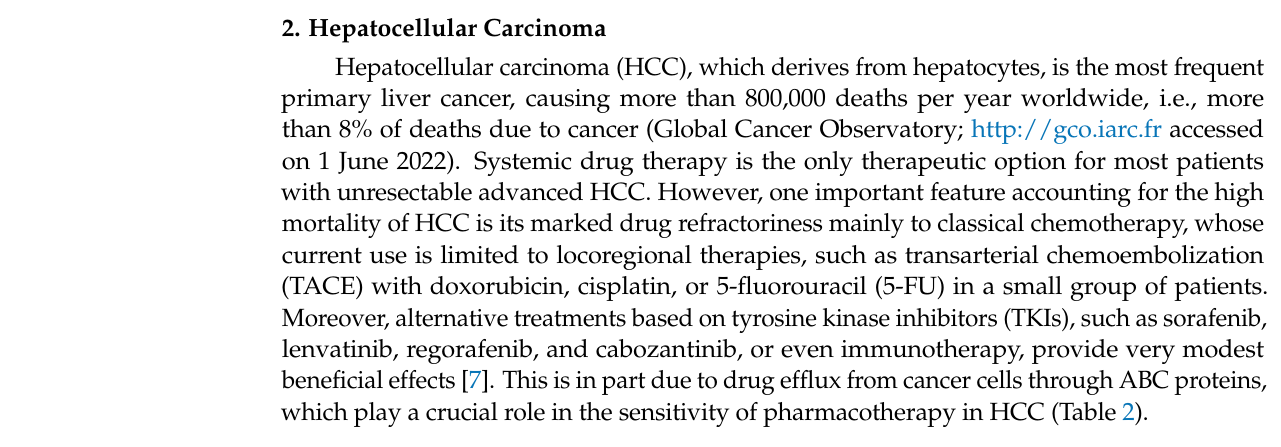
Table 2. Role of ABC proteins in the chemoresistance of hepatocellular carcinoma